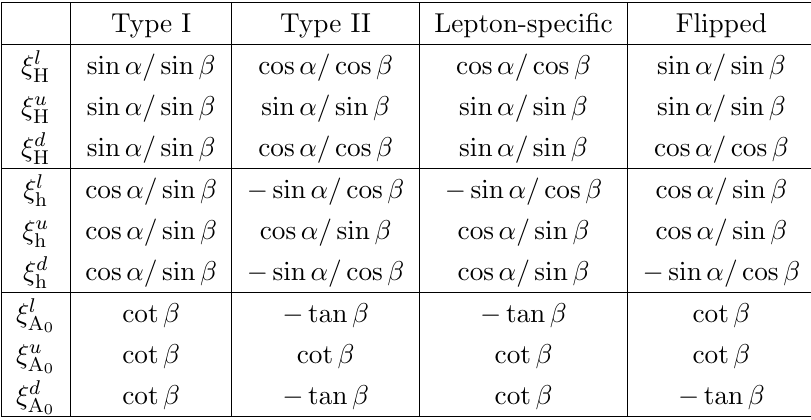
Table 2 . The coupling strengths (cid:24) f of H ; h ; A 0 to the fermions relative to the SM value of m f =v , see eq. (2.28). Note that the sign of (cid:24) f is de(cid:12)ned relative to the coupling of the A 0